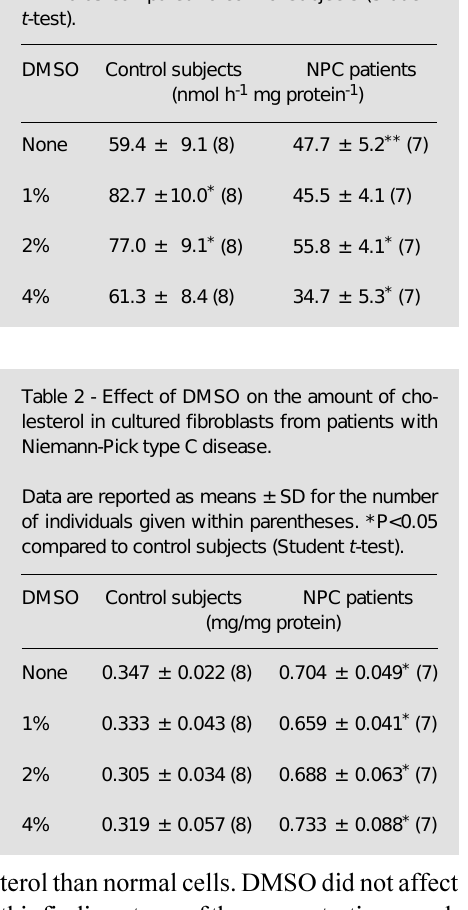
1 - Effect of DMSO on fibroblast sphingo- myelinase activity of patients with Niemann-Pick type C